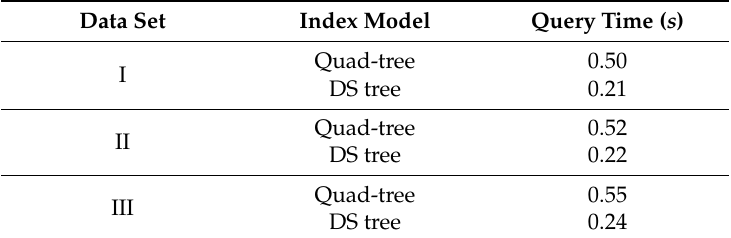
Table 2. Comparison of image spatial query times of the DS tree and the quad-tree. Data Set